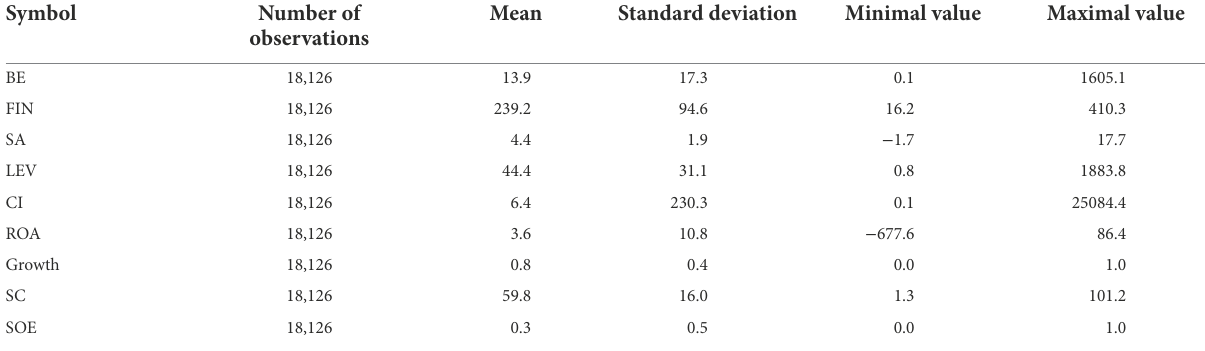
TABLE 3 Descriptive statistics for variables.